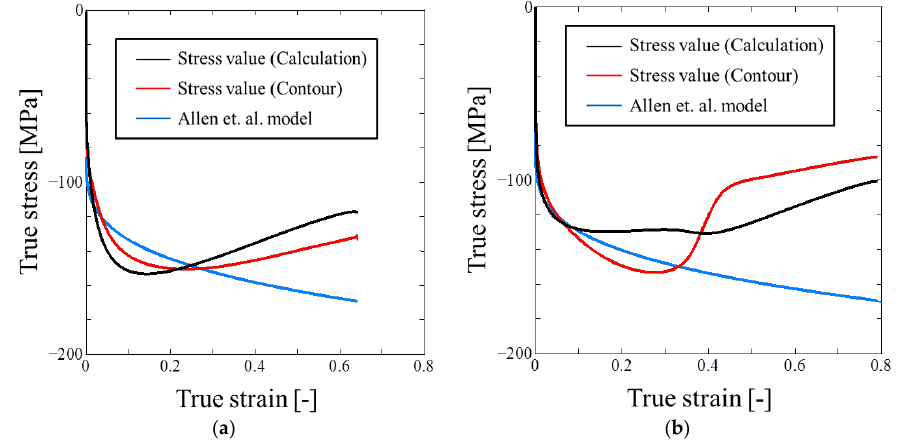
Figure 13. Stress-strain curve at each elapsed time by combining Figures 11 and 12. ( a ) 20 µ s, ( b ) 50 µ